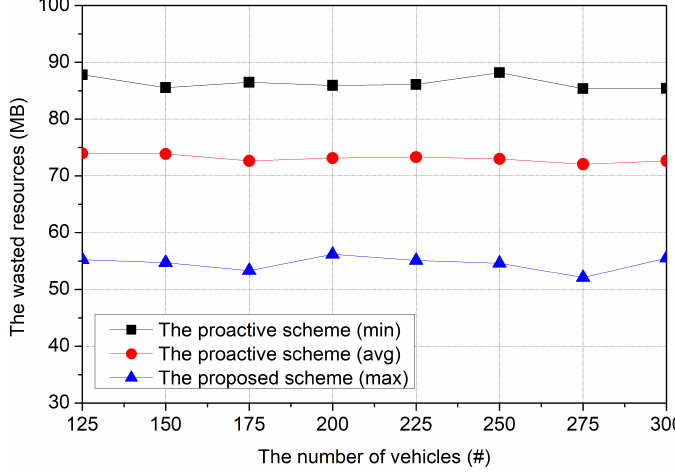
Figure 4. The wasted resources for the number of